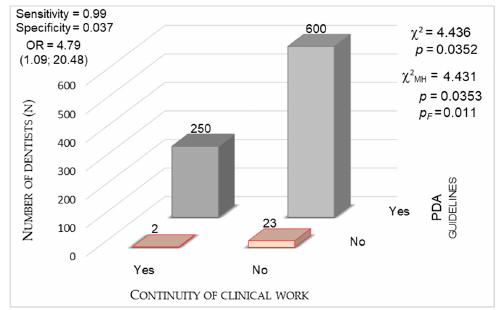
Figure 7. Continuity of clinical work during the COVID-19 outbreak vs. acknowledgment of Polish Dental Association (PDA) guidelines ( p < 0.0001, chi-square test).